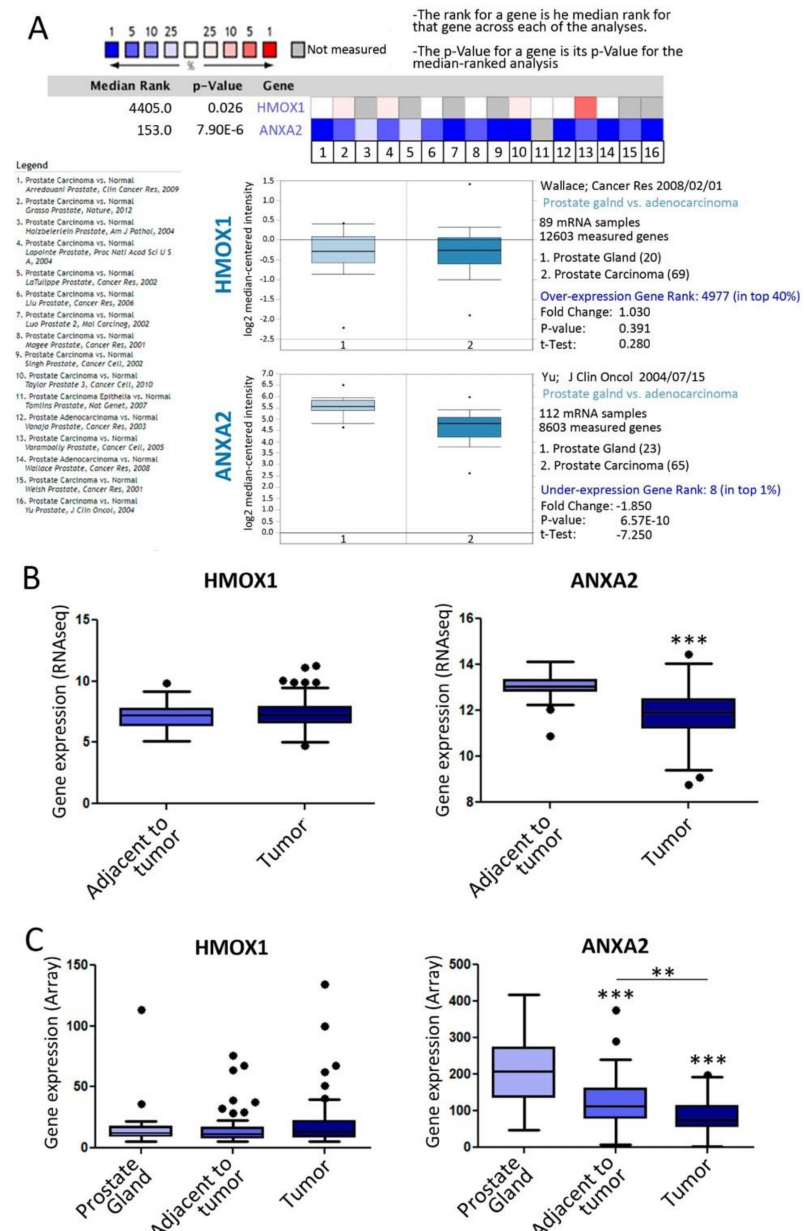
Figure 4. Clinical relevance of ANXA2 and HMOX1 in PCa. ( A ) Meta-analysis of multiple microarray datasets for HMOX1 and ANXA2 expression (Oncomine). One representative box plot is shown for each gene comparing its expression profile between group 1: Prostate Gland and group 2: Prostate Adenocarcinoma ( n = 1128). ( B ) HMOX1 and ANXA2 expression levels in Tumor and Adjacent to tumor human samples on TCGA-PRAD RNAseq dataset ( n = 497). ( C ) HMOX1 and ANXA2 expression levels in normal prostate gland, adjacent to tumor, and tumor samples on the GSE6919 microarray dataset ( n = 171). Significant di ff erences: ** p < 0.01, *** p <